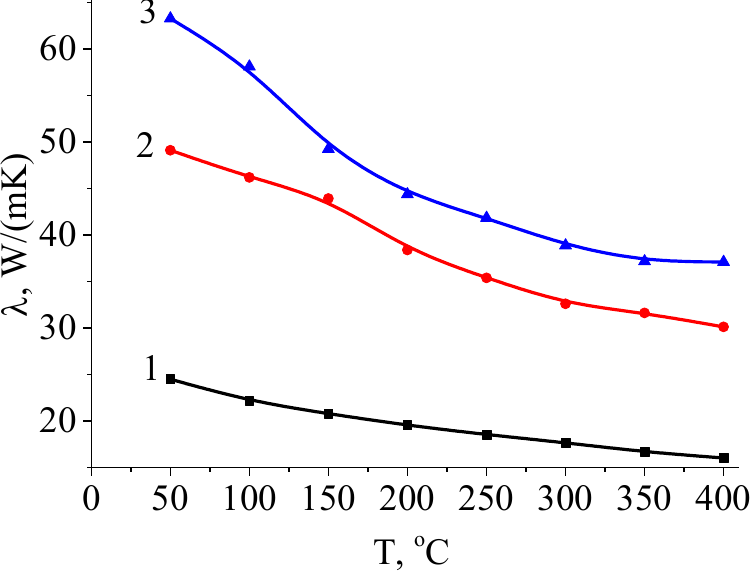
Figure 8. Temperature dependence of thermal conductivity for composites of different compositions: (1) composite 75A; (2) composite 50A; (3) composite 25A.